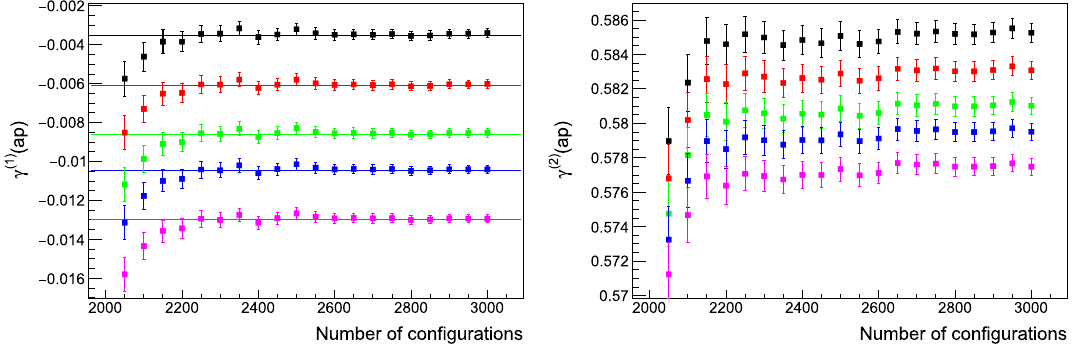
is used for fitting. Most analytic finite-volume predictions have been drawn as lines to help the eye in the comparison. The difference with the prediction in the right panel is to be ascribed to the fact that we are able to resolve finite volume effects